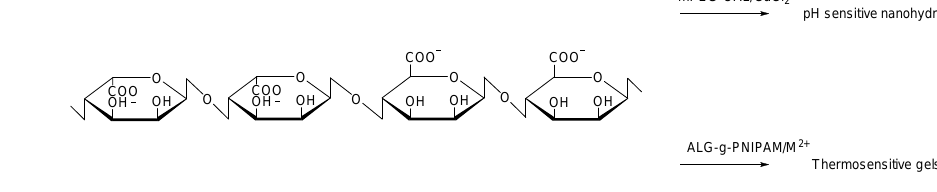
Figure 7. Use of chitosan and alginate to protect insulin. Animal experiments have shown that the glucose blood level in rats can be reduced and kept stable at a normal level for almost 60 h [61,62]. Similarly, this method can also be used as an encapsulation strategy for macromolecular proteins or bacteria [63,64]. Using alginate alone as a material to make sustained/controlled-release preparations is very rare now. To achieve a more precise drug release or better factor response, alginate needs to hybridize with other materials or iron, or be modified before use. For example, Peng et al. made hybrids of disulfide-modified alginate-based nanogels with superpara- magnetic iron oxide nanoparticles to achieve dual responsive properties. This hybrid nanogel showed magnetic-targeted characteristics, loading large amounts of drugs, pH/redox dual-responsive properties, high toxicity to cancer cells, low toxicity to normal cells, and magnetic resonance imaging functions. Compared with early superparamag- netic iron oxide nanoparticles, this nanoparticle covered with alginate by disulfide bonds responded to two factors: the acidic microenvironment of tumor cells, and the high con- centration of glutathione [39].